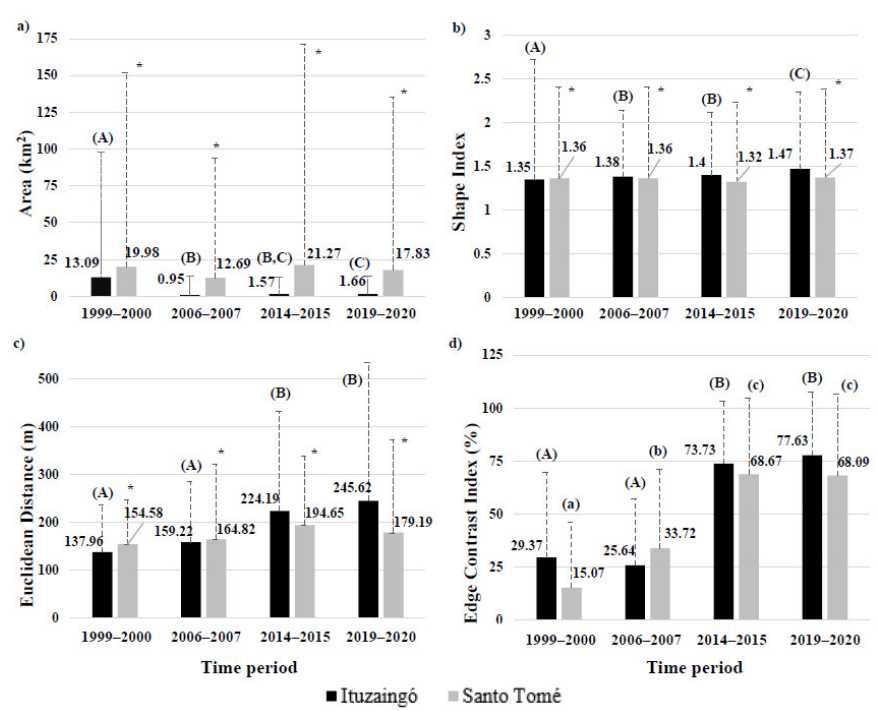
Figure 6. Mean values for grassland landscape metric at patch level, ( a ) PS, ( b ) SHAPE, ( c ) ENN, ( d ) ECON, per district (Ituzaingó, black bars; Santo Tomé, gray bars); vertical bars represent the standard deviation. Significant differences between time periods based on Kruskal Wallis test is represented by different letters ((A), (B), (C), Ituzaingó district; (a), (b), (c), Santo Tomé district); no significant differences between time periods based on Kruskal Wallis test is represented by * (see Appendix C for the Kruskal Wallis tests results).